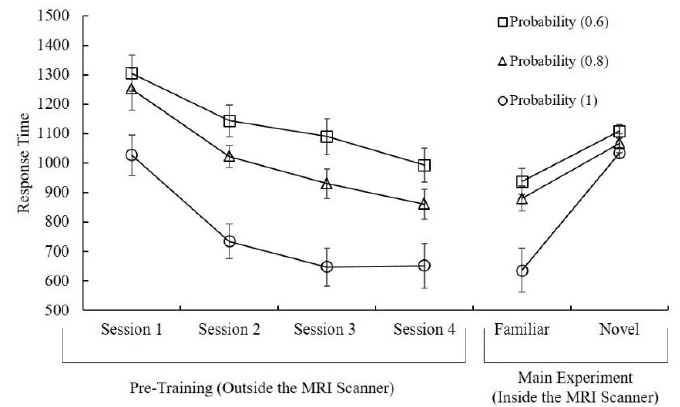
Figure 2. Response times for the pre-training (Session 1, 2, 3, and 4) and main experiment showed for all outcome probabilities. Error bars indicate standard deviations.